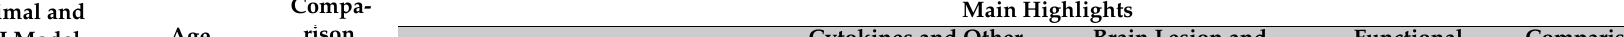
Table 1. Post-traumatic inflammatory, neuronal and functional consequences in neonatal animals. Abbreviations: ↑ : increase; ↓ : decrease; CCI: controlled cortical impact; d: days post-injury; h: hours post-injury; NC: not compared; NMDA: N-methyl-D-aspartate; P: postnatal days; TBI: traumatic brain injury; WD: weight drop . Animal